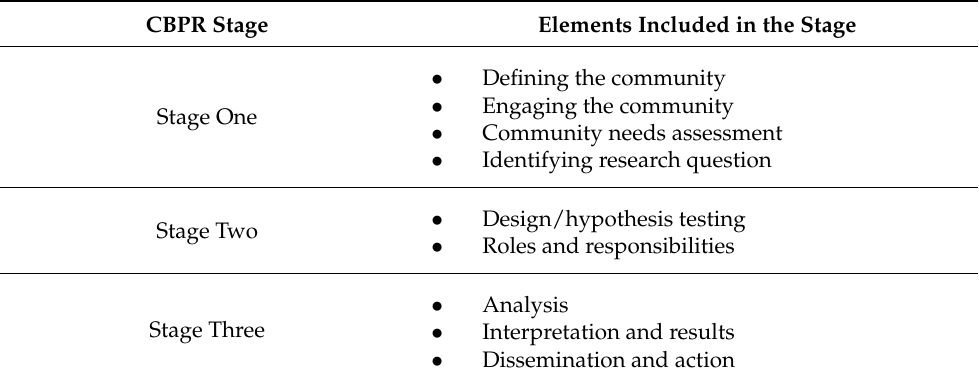
Table 2. Community-based participatory research